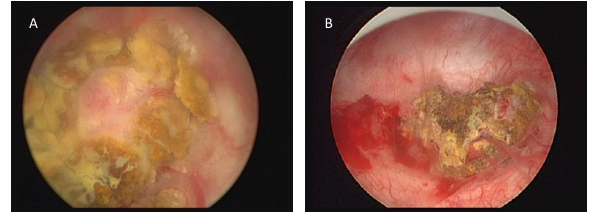
Figure 2. A: Cystoscopic image of bladder wall calcification. B: calcification with adjacent inflammation and bleeding. Case 2.